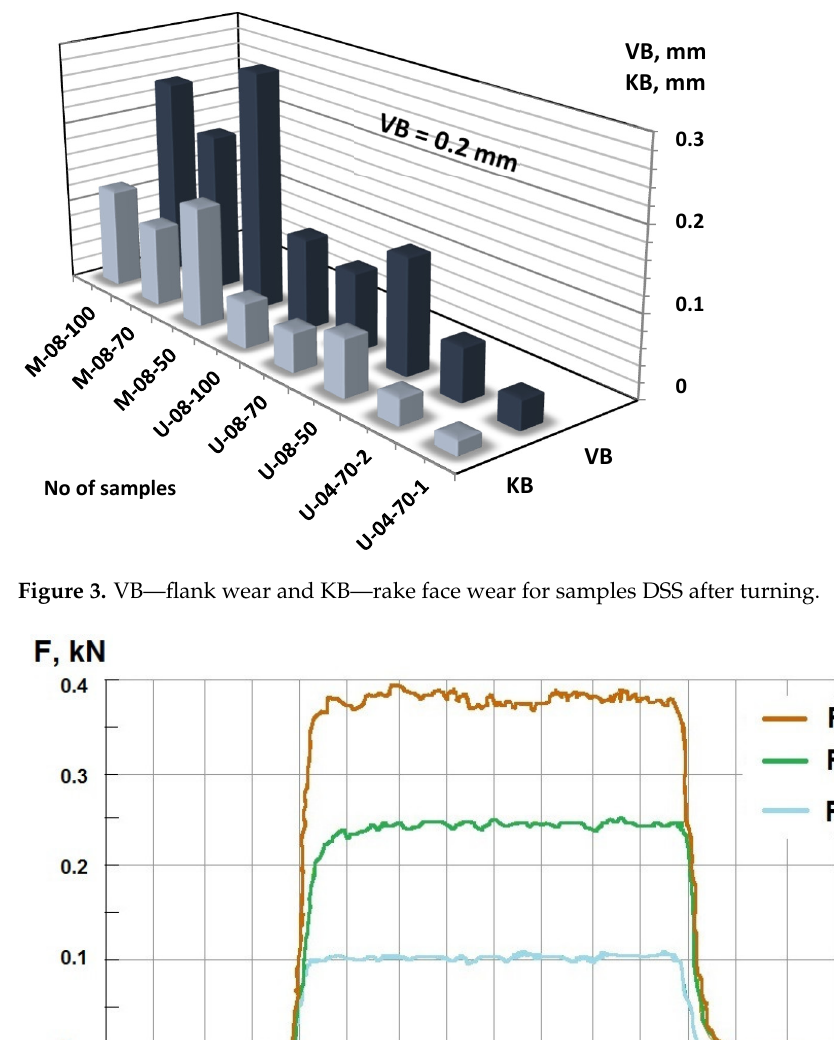
Figure 4. Cutting forces after turning for insert CC3 for the samples with DSS, for f = 0.1 mm/rev, a p = 0.5 mm; v c = 70 m/min ( Ra = 1.05 μm).